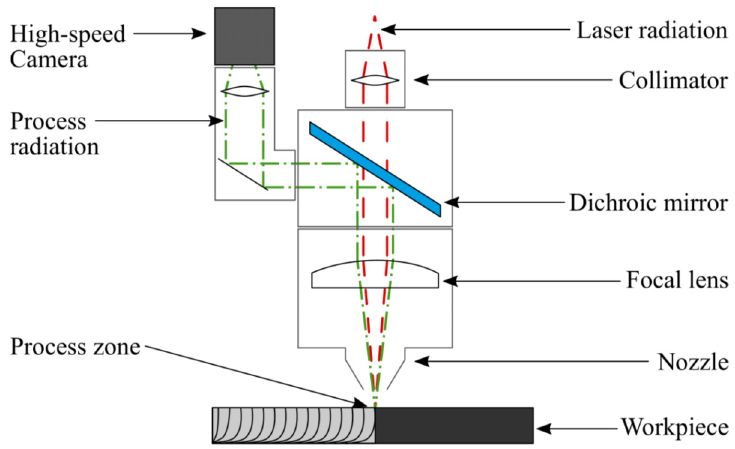
Figure 1. Optical setup of the cutting head.